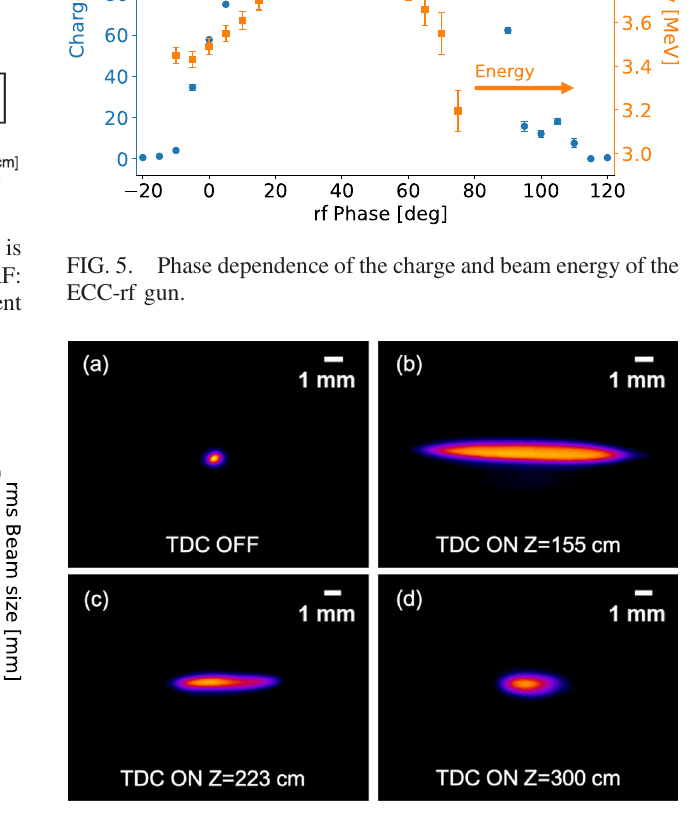
FIG. 4. Expected performance of the ECC-rf gun simulated by GPT. Expansion of the bunch length caused by space charge effect can be seen at Z > 270 cm.